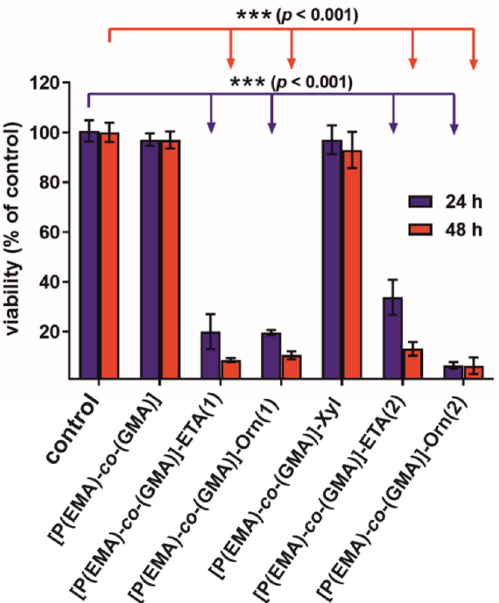
Figure 5. MTT cytotoxicity test performed according to ISO 10993-5 standard using fluid extracts of HGs and human skin fibroblasts (*** statistically significant results compared to the control, according to one-way ANOVA followed by Dunnett’s test).